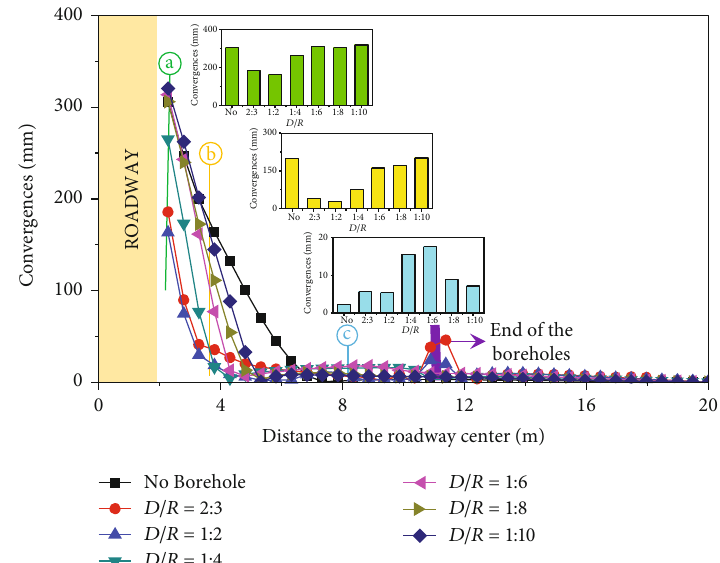
Figure 9: Rib convergence curves under the di ff erent borehole D / R ratios. (a – c) Represents the rib convergence at the locations of 0m, 1.5m, and 6m distancing from the rib surface, respectively.